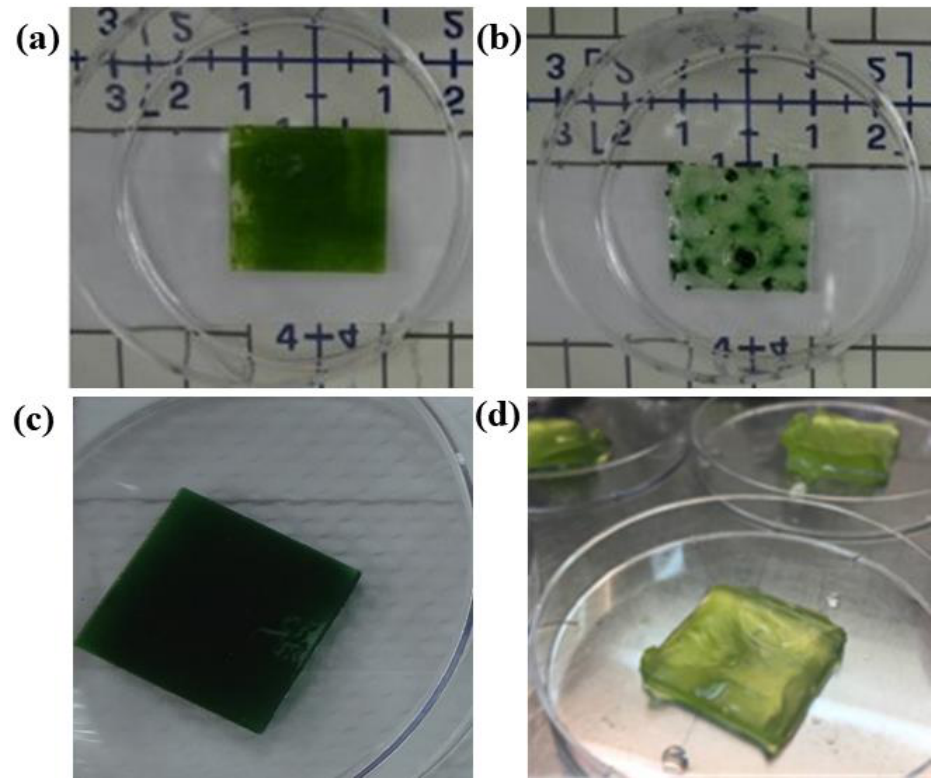
Figure 5. Formation of algal biofilms on anode materials. ( a ) Chlorella UMACC 313 on an ITO-coated glass anode, ( b ) Spirulina UMACC 159 on an ITO-coated glass anode, ( c ) Synechococcus UMACC 105 on an rGO-coated glass anode and ( d ) Chlorella UMACC 313 immobilized in alginate on top of the ITO coated glass anode. Photos are the properties of the authors of the paper.